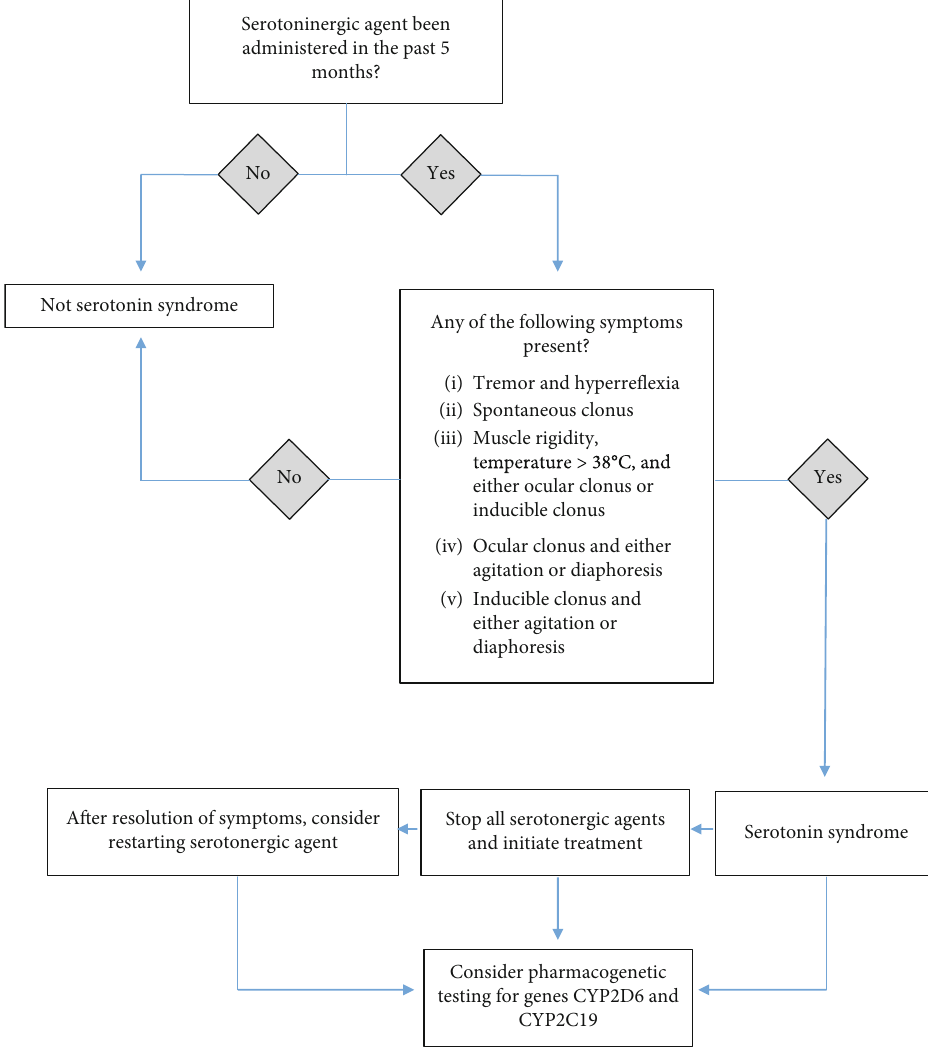
Figure 2: Algorithm for incorporating pharmacogenetic testing in the management of serotonin syndrome. Diagnosis criteria adapted from Dunkley et